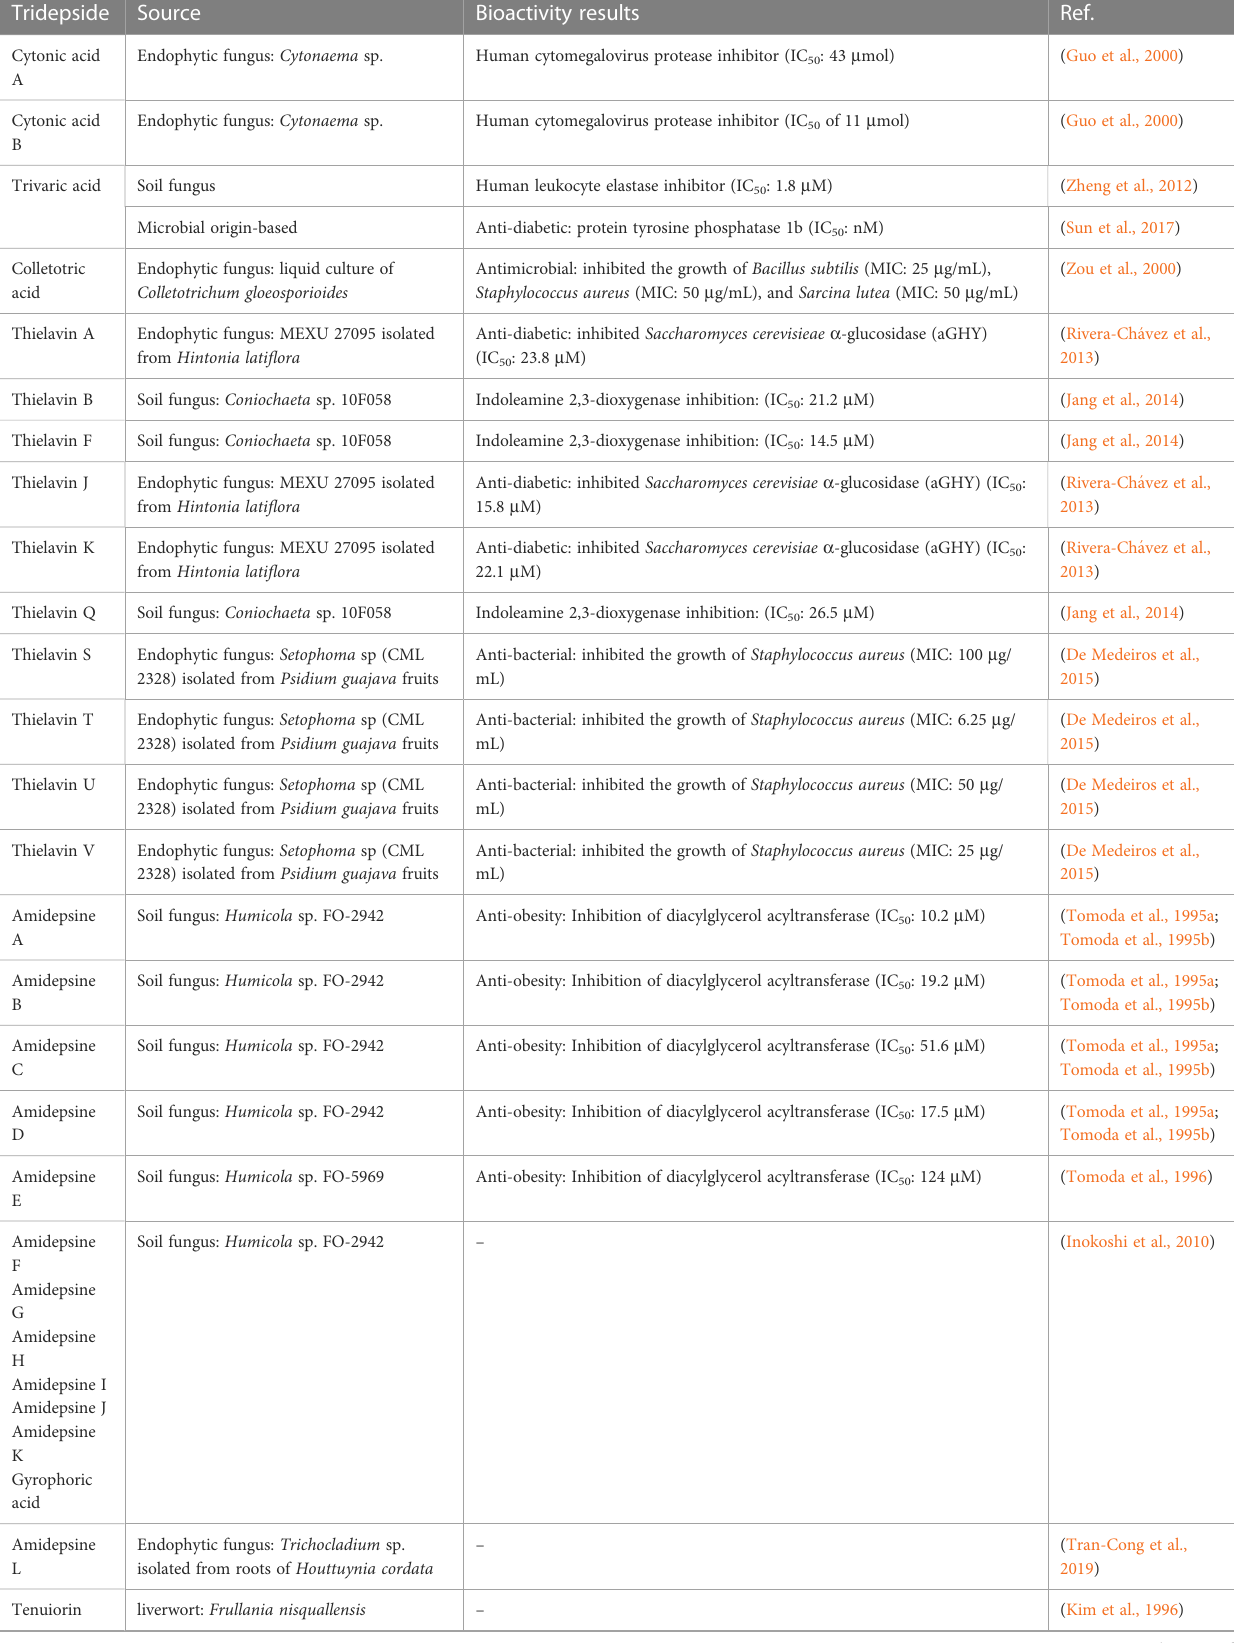
TABLE 1 An overview of the non-lichenic tridepsides reported over the past few years.